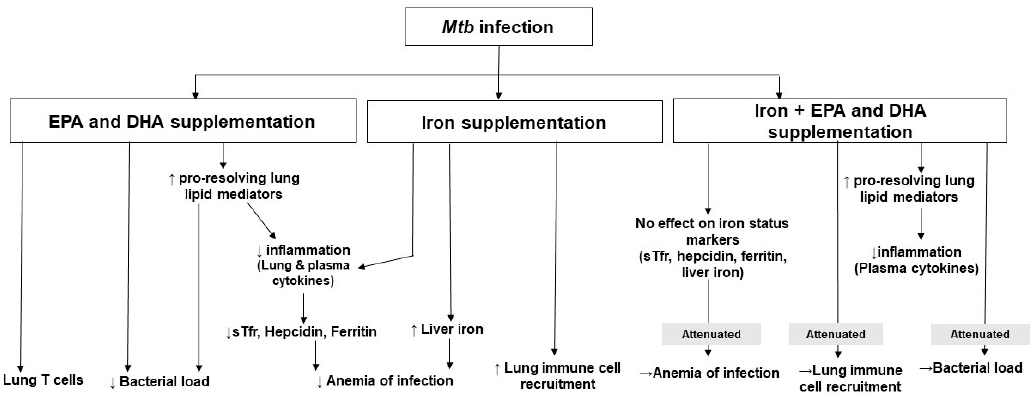
Figure 8. Summary of the findings of this research. DHA: docosahexaenoic acid; EPA: eicosapentaenoic acid; Mtb: Mycobacterium tuberculosis ; sTfr: soluble transferrin receptor.